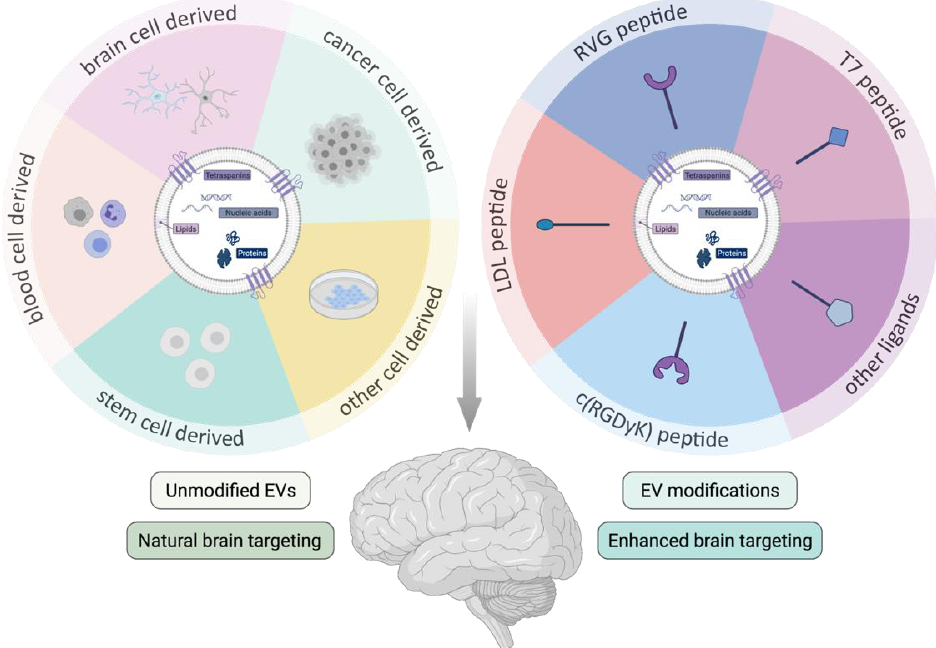
Figure 1. Schematic overview of the discussed literature on (un)modified extracellular vesicles (EVs) in this review. Unmodified EVs derived from various specific cell sources are described to possess a natural brain targeting capacity. Additionally, EVs can be engineered with diverse targeting lig- ands to obtain enriched brain targeting.